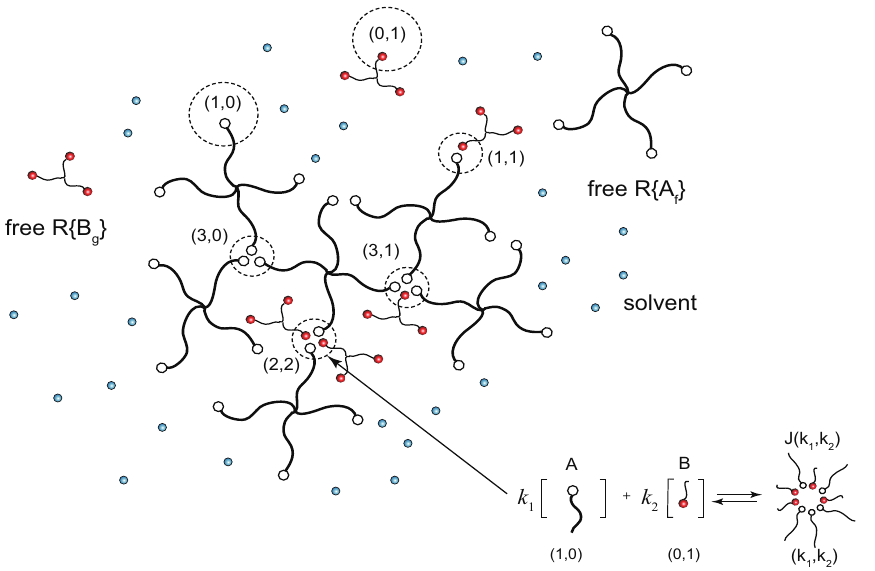
Figure 1. Connected tree-like clusters consisting of tetrafunctional molecules R{A 4 } and trifunctional molecules R{B 3 } in a solvent. Reversible chemical reaction in forming cross-link junctions contains arbitrary number k 1 of functional groups A and k 2 of groups